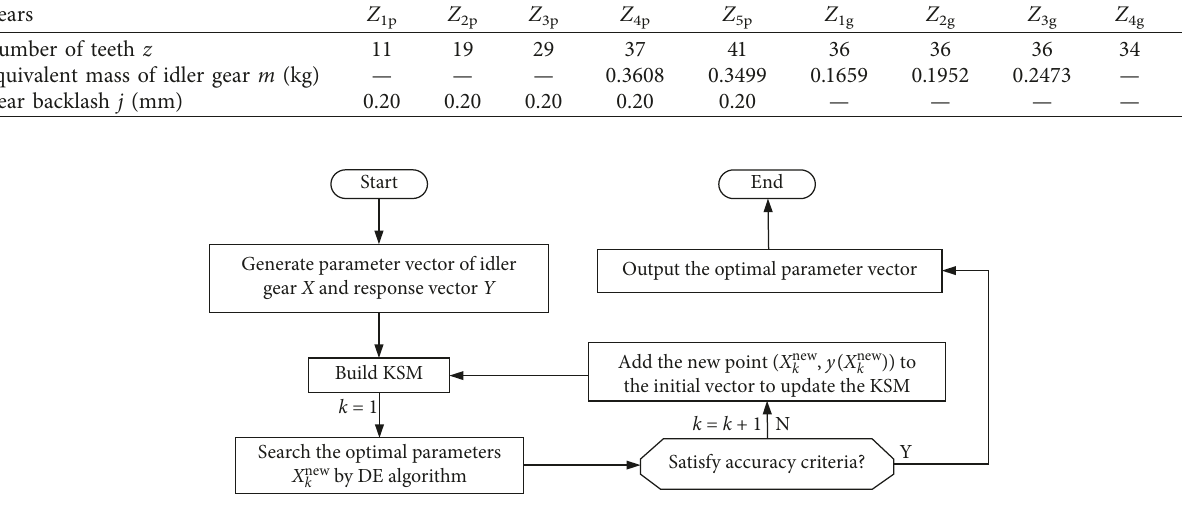
Figure 16: The flowchart of rattle noise optimization.